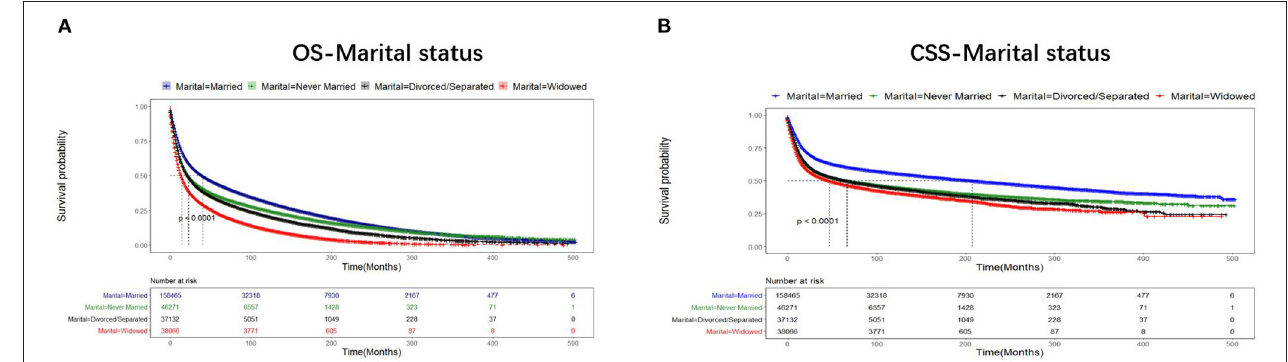
FIGURE 2 | Comparison of OS and CSS of the patients with UDTT in different marital statuses, 1975–2016 ( p < 0.001). Censoring marks are indicated with small vertical lines. (A) OS- Marital status; (B) CSS- Marital status.